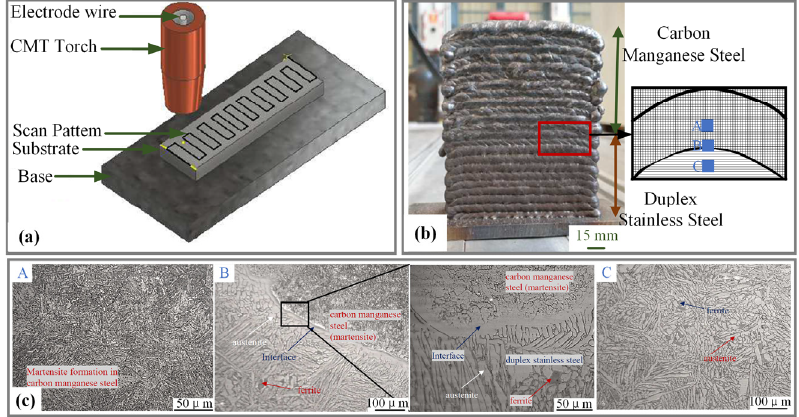
Figure 20. ( a ) Schematic of WAAM system based on CMT, ( b ) Front view of FGM sample, ( c ) Microstructure at locations A, B and C in figure ( b ) [86].